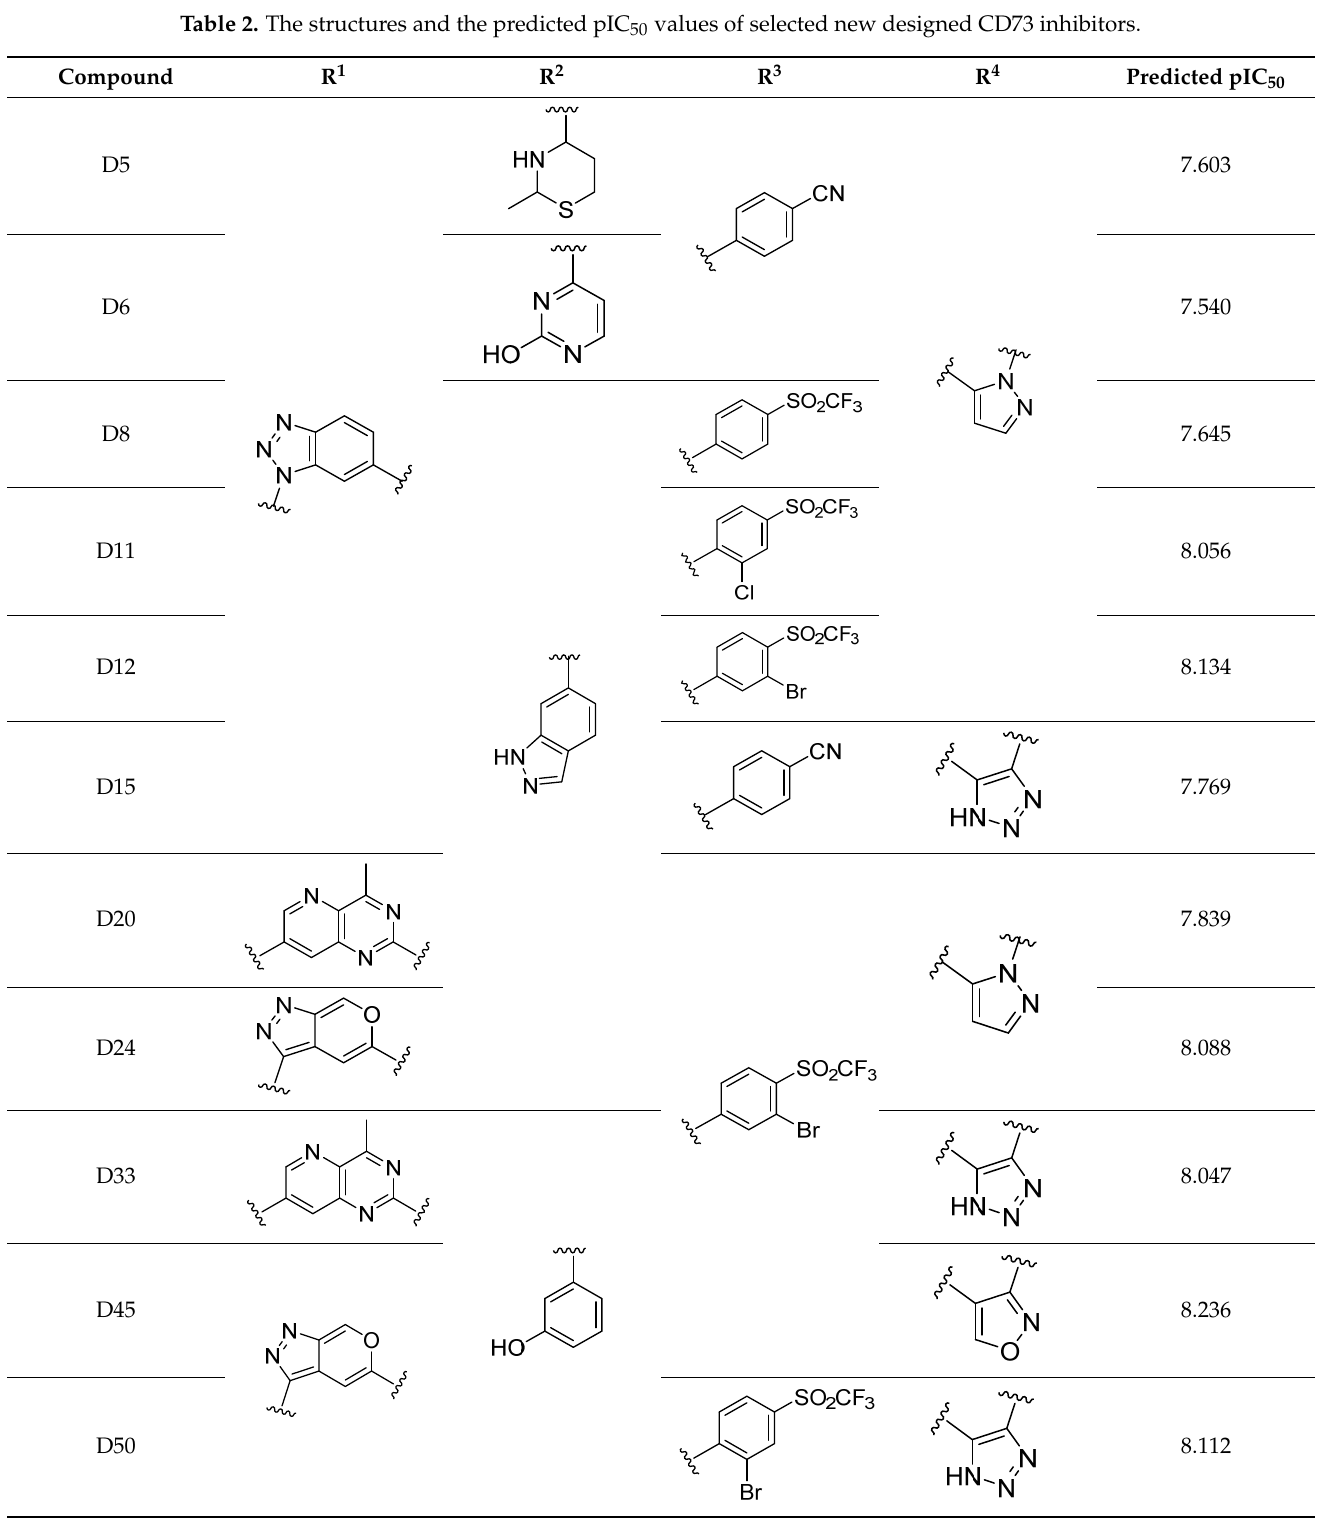
Table 2. The structures and the predicted pIC 50 values of selected new designed CD73 inhibitors.